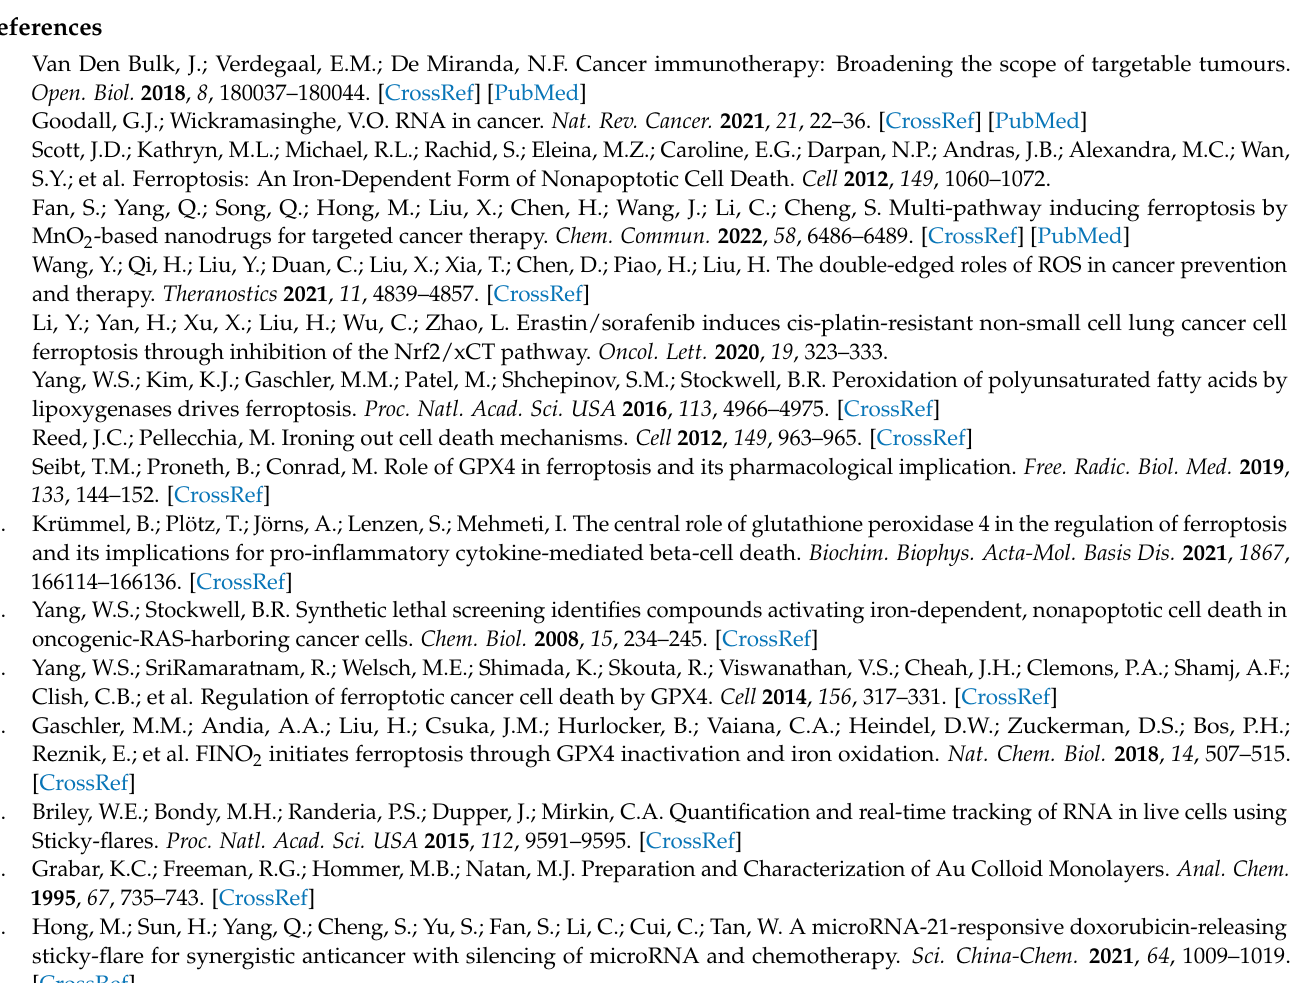
cells. Table S1: IC50 values of erastin against five different cancer cell lines. Table S2: Inhibition rate of different systems on the proliferation of different cancer cells at 48